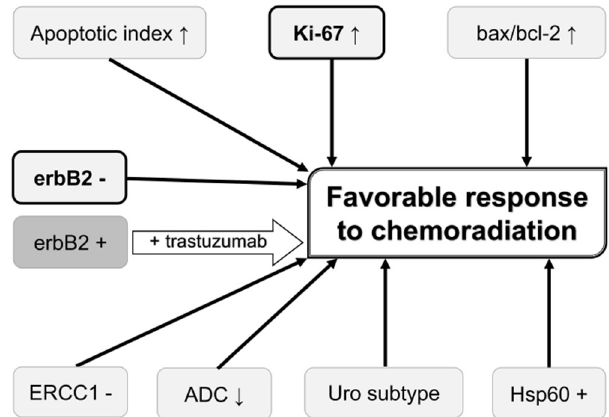
Figure 1. Biomarkers that may be used for predicting and improving the chemoradiation response. Biomarkers in bold letter are also associated with favorable prognosis on bladder preservation therapy. Overexpression of erbB2 is associated with unfavorable chemoradiation response, which can be overcome by trastuzumab. ADC, apparent diffusion coefficient value on diffusion-weighted magnetic resonance imaging; erbB2, erythroblastic leukemia viral oncogene homolog 2; ERCC1, excision repair cross-complementing group 1; Hsp60, heat shock protein 60; Uro subtype, urobasal subtype in the Lund University subtyping model; ↑ , high value; ↓ , low value.